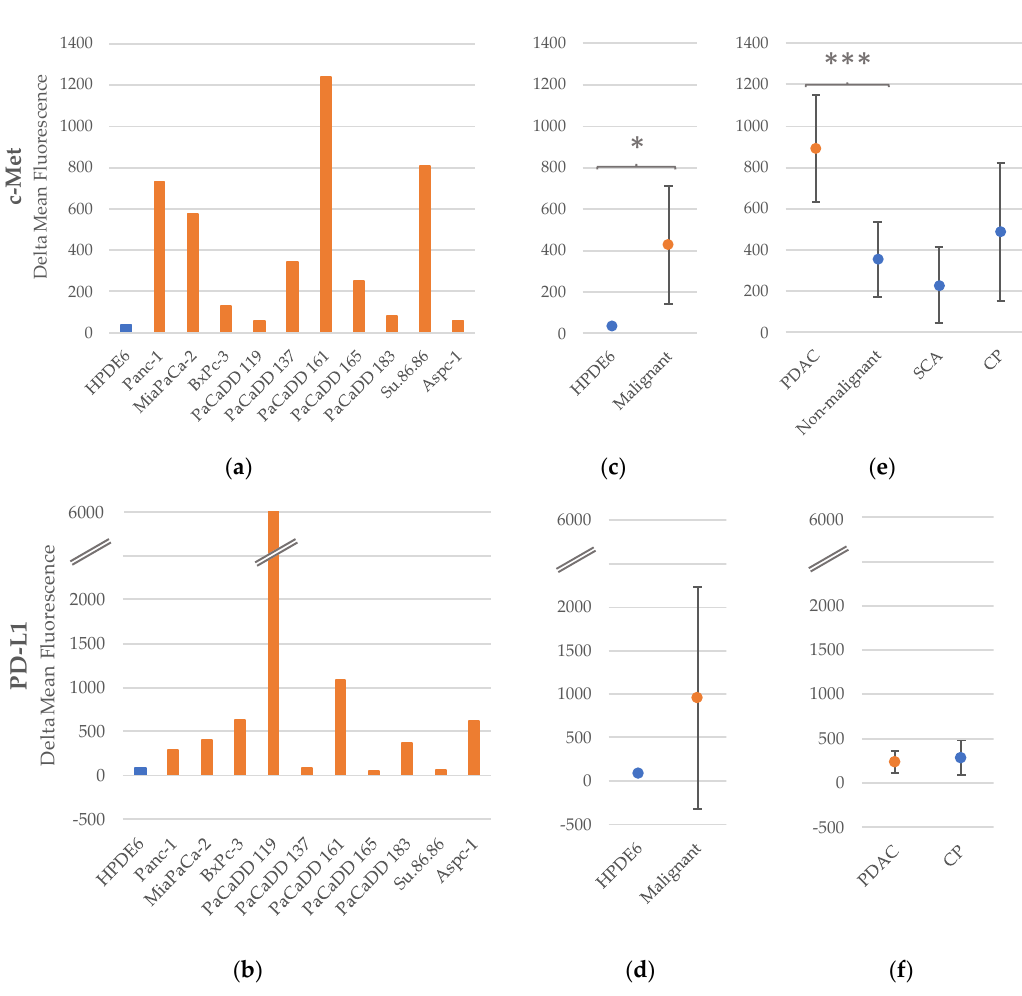
Figure 1. Fluorescence intensity of human pancreatic cell lines using the primary antibody anti-c-Met ( a ) and PD-L1 ( b ); ( c ) mean estimator and 95% confidence interval (CI) of malignant cell lines compared to benign human pancreatic duct epithelial cell line (HPDE) using c-Met ( c ) and PD-L1 ( d ); ( c ) mean estimators and 95% CI of the fluorescence intensities of various disease entities using c-Met ( e ) and PD-L1 ( f ); * significant at 5% level ( p < 0.05); *** significant at 0.1% level ( p < 0.001).